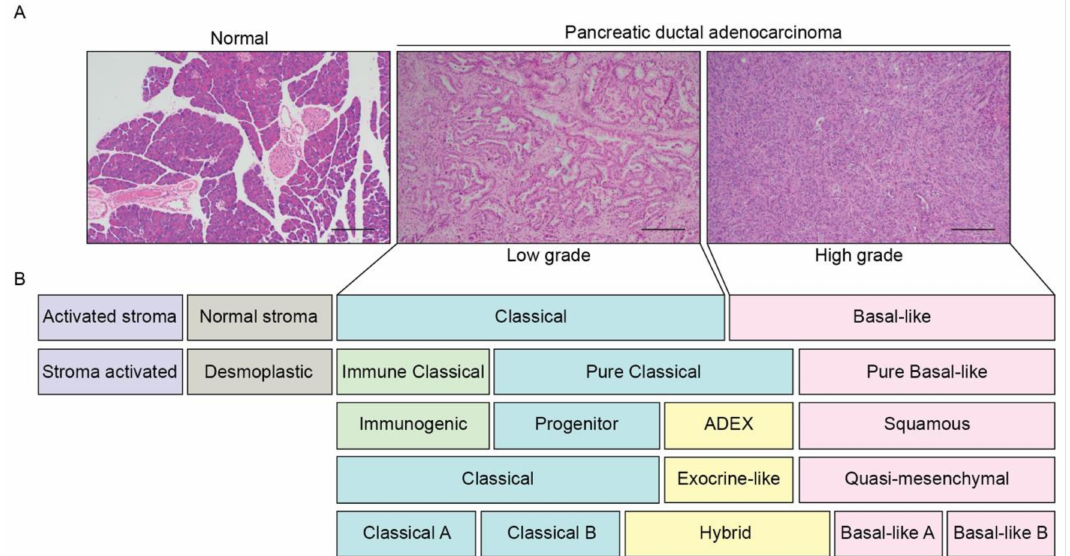
Figure 1. PDAC patients can be subclassified based on histopathological and molecular features. ( A ) Representative H&E sections of a normal human pancreas and a primary PDAC tumor (low grade and high grade). Scale: 200 µ m. ( B ) Schematic overview of the PDAC molecular subtypes described to date [14–16,19,20]. Subtypes with similar expression signatures are grouped by color. Low grade PDAC tumors are enriched for a ‘classical’ signature, whereas high grade tumors are enriched for a ‘basal-like’